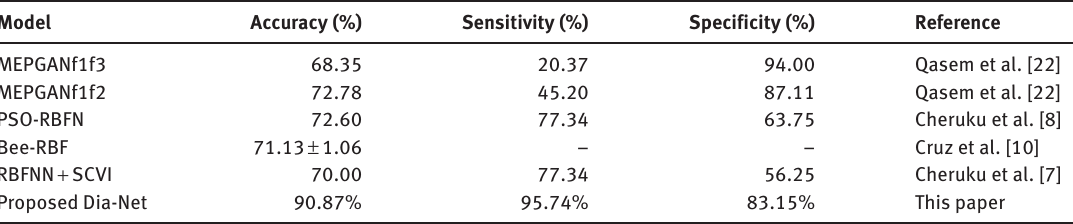
Table 6: Comparison of the proposed method with other RBFNN variants of the same domain. Model